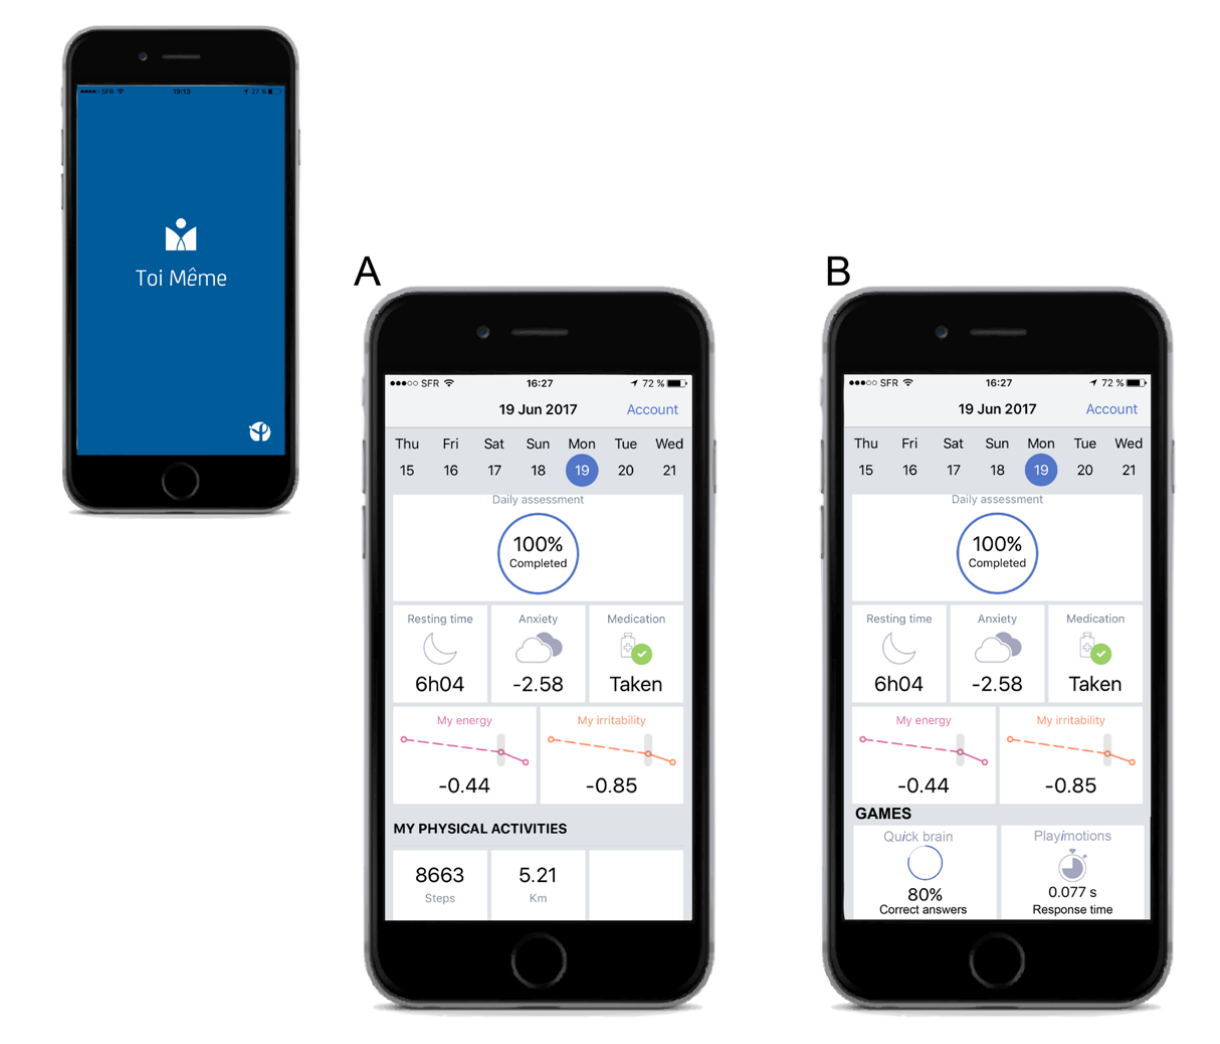
Figure 3. Example of the Toi Même app